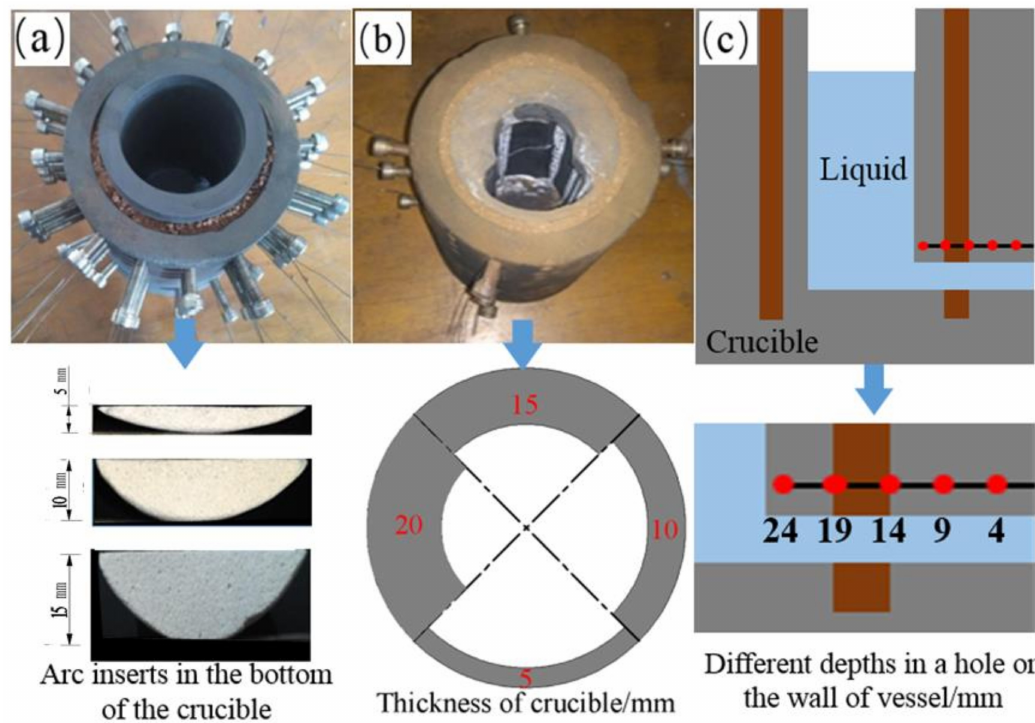
Figure 2. Three scenarios for crucible erosions of the laboratory vessel: ( a ) three arc inserts, ( b ) four di ff erent thicknesses along the circumference, and ( c ) di ff erent depths (24, 19, 14, 9, and 4 mm) in a hole on the wall of the vessel).